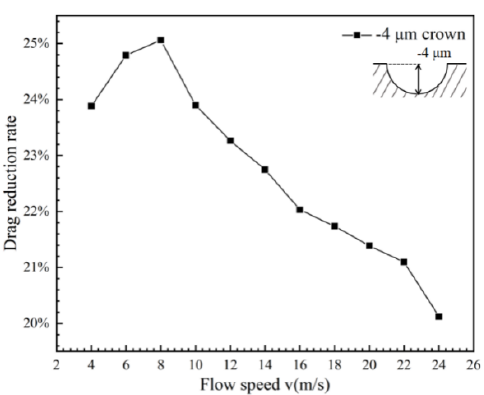
Figure 10. Relationship between surface drag reduction rate and flow velocity of hemispherical negative coronal protrusions.